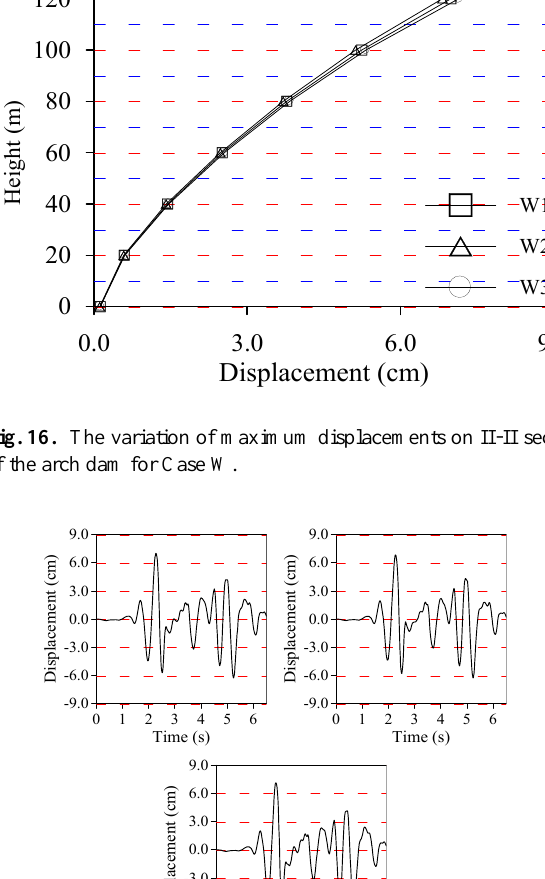
Fig. 17. The time histories of displacements at the nodal point 48 of arch dam for Case W. The variation of maximum and minimum principal stresses along I-I section (Fig. 4) are plotted in Fig. 18 for each case. It can be seen from Fig. 18 that the distribution of the